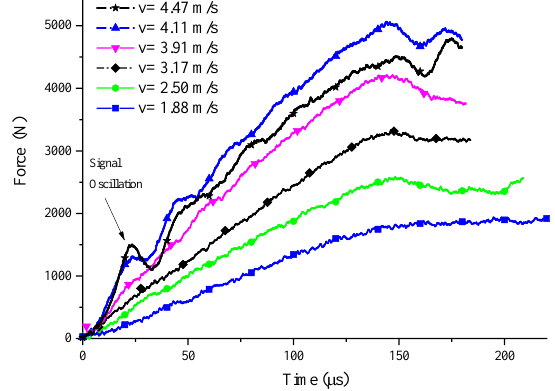
Figure 4. Force–time curve of 15 ◦ SCSs at different impact speeds.